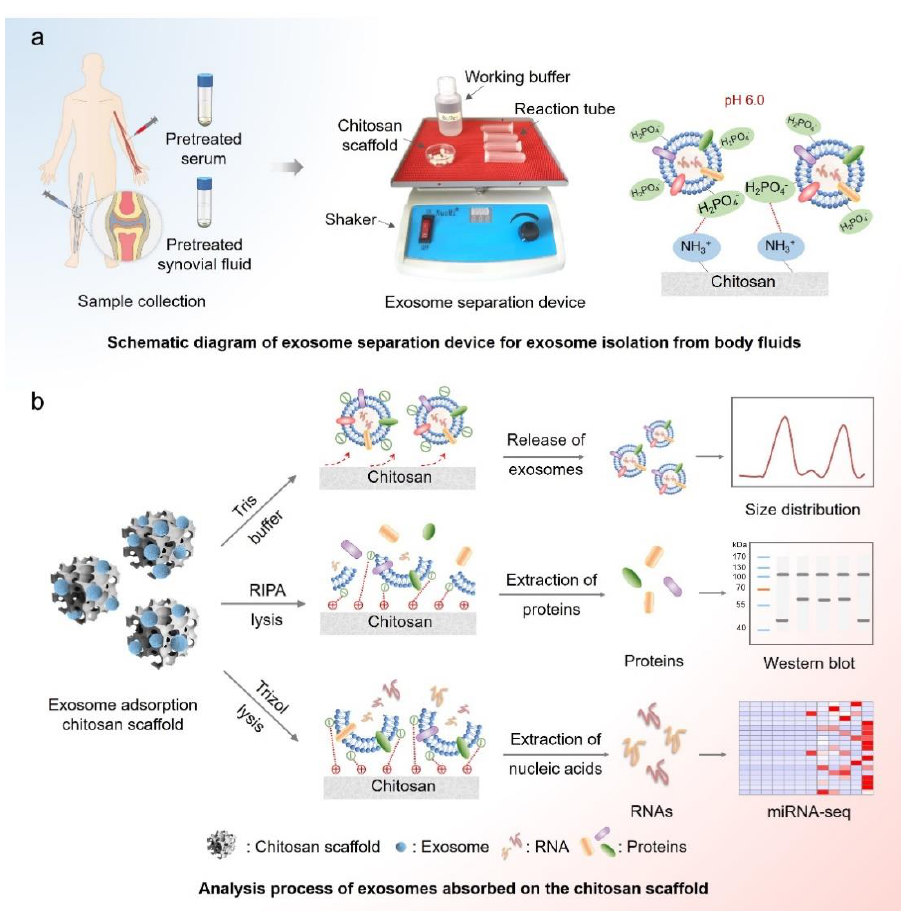
Figure 1. An illustration of isolating exosomes from serum and synovial fluid using the exosome separation device. ( a ) Schematic diagram of the exosome separation device for exosome isolation from the serum and synovial fluid of a human. The device is composed of a chitosan scaffold, reaction tube, working buffer, and a shaker. In an acidic environment, -NH 3+ on chitosan can combine with anionic phosphate groups on a phospholipid bilayer of exosomes thus absorbing exosomes on its surface. ( b ) Analysis process of exosomes absorbed on a chitosan scaffold. The exosomes captured by the chitosan scaffold can be released by alkaline buffer for particle size detection or lysed online for nucleic acids and proteins analysis.